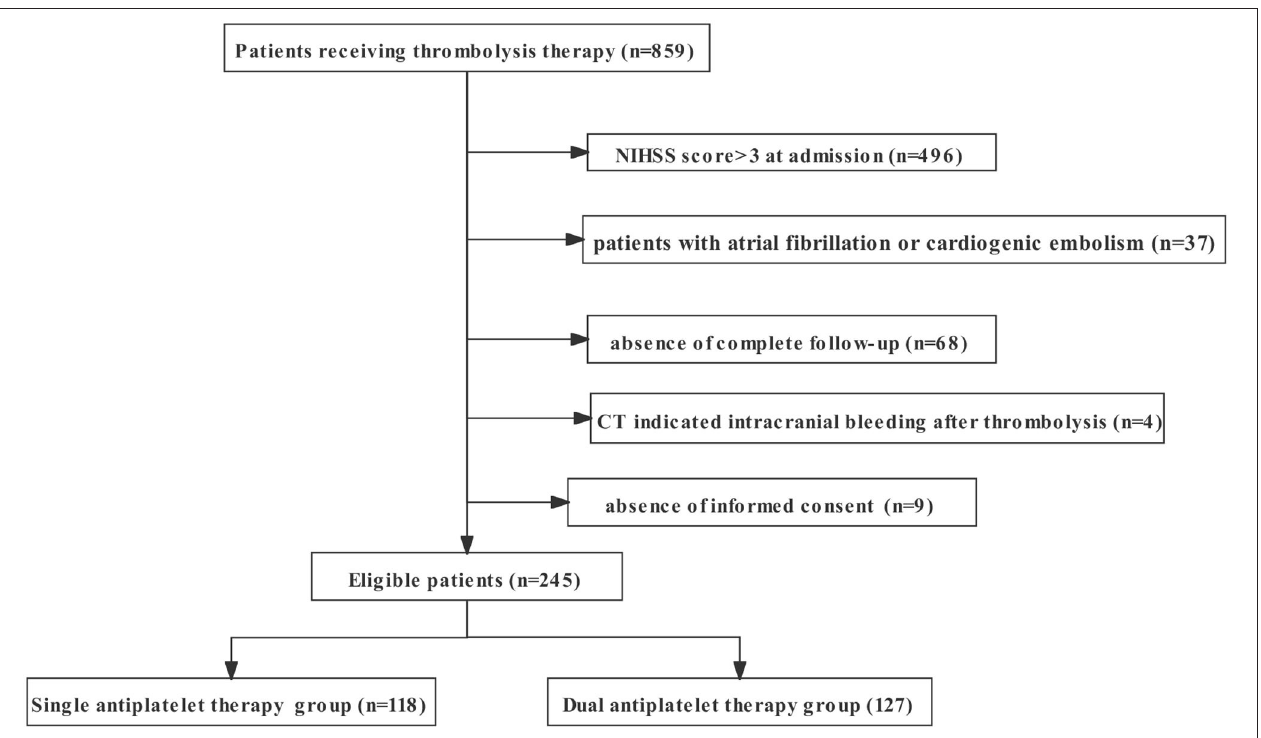
FIGURE 1 | The flowchart of recruitment information on patients enrolled in the study. NIHSS, National Institutes of Health Stroke